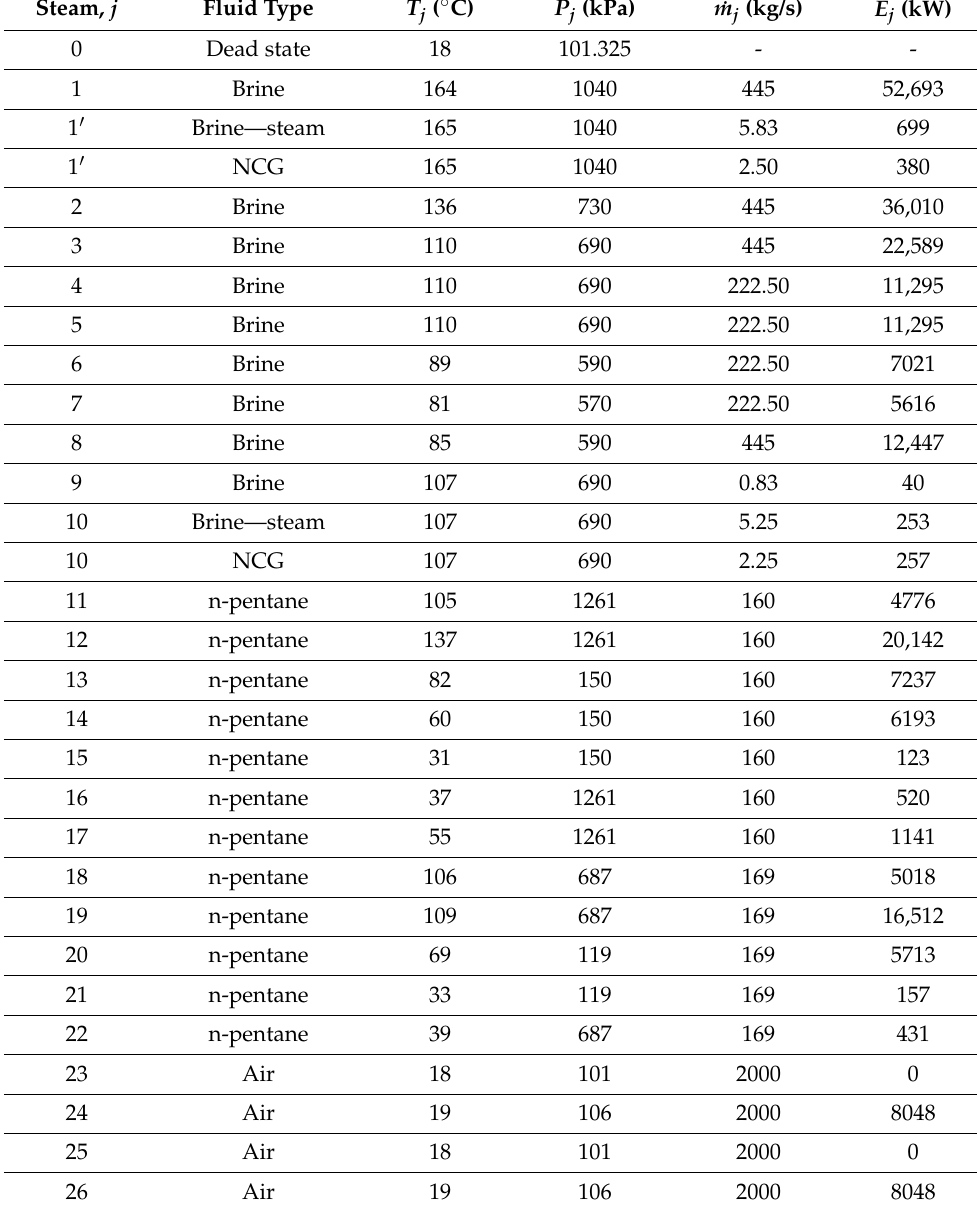
Table 1. The thermodynamics variables at different steam points for the Sinem